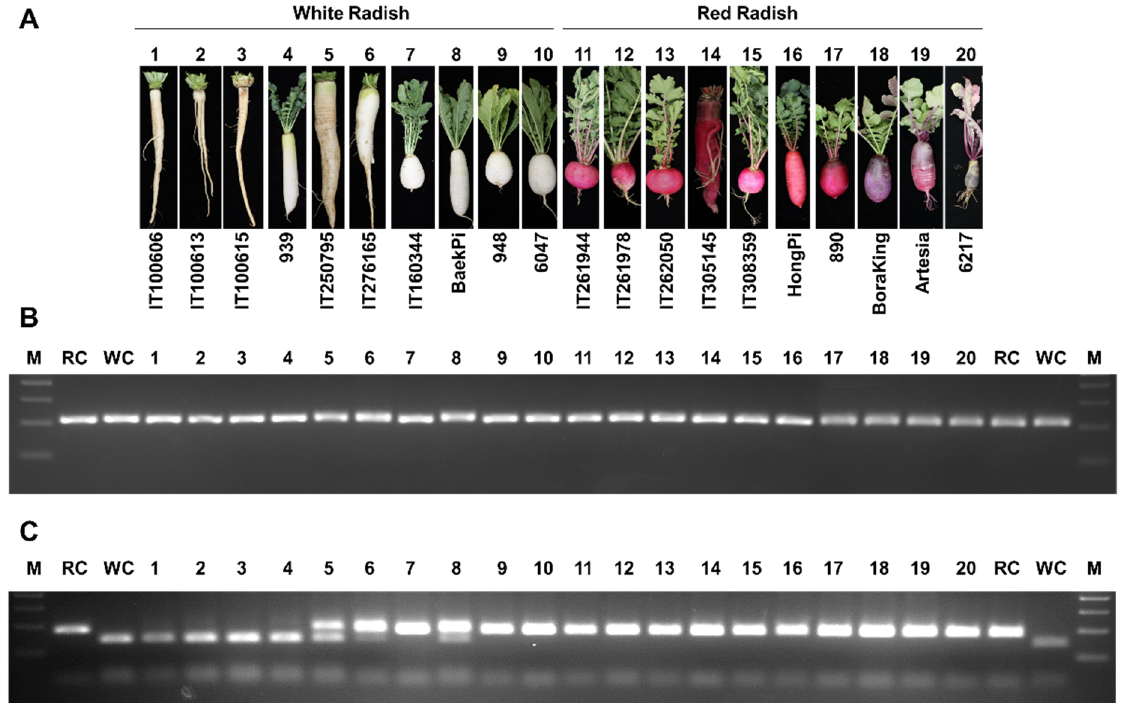
Figure 10. Sequence variation at RsMYB1 predicts taproot color across 20 radish cultivars. ( A ) Representative photographs of radish taproots showing the different colors of the indicated cultivars. ( B ) Gel electrophoresis of amplified fragments of the RsMYB1 gene. ( C ) Genotyping results of the 20 radish cultivars with the CAPS marker for RsMYB1 . FC and SC are PCR amplicons from plasmids harboring RsMYB1 Short or RsMYB1 Full , respectively, as positive controls. M: 100 bp DNA size marker.